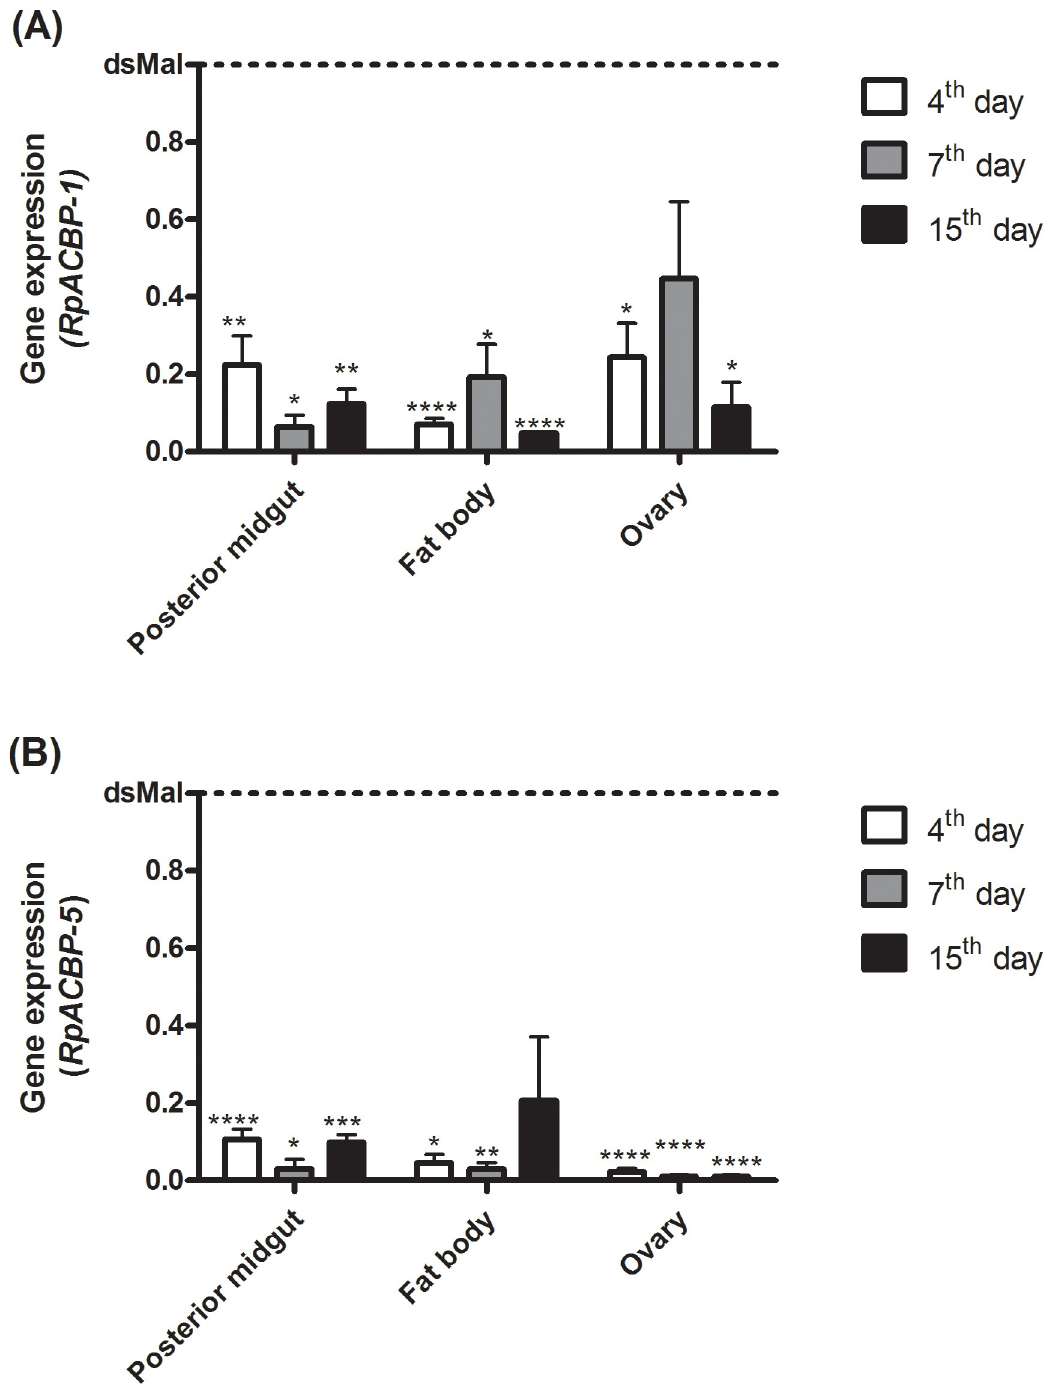
Fig 7. RpACBP-1 and RpACBP-5 gene expression after double knockdown by RNAi. Fasting adult females were injected with a mixture of dsRNAs containing 1 μ g of dsRpACBP-1 and 1 μ g of dsRpACBP-5 or with 2 μ g of dsMal, used as a control. The insects were fed three days after injection and dissected on the 4 th , 7 th and 15 th day after feeding. The RpACBP-1 and RpACBP-5 mRNA levels were quantified by qPCR, using the Rp18S expression as a reference gene. The bars are means ± SEM. ( � ), ( �� ), ( ��� ), and ( ���� ): significantly different from dsMal by Student’s t -test with p < 0.05, 0.01, 0.001, and 0.0001, respectively; n = 3–4. (A) RpACBP-1 gene expression. (B) RpACBP-5 gene